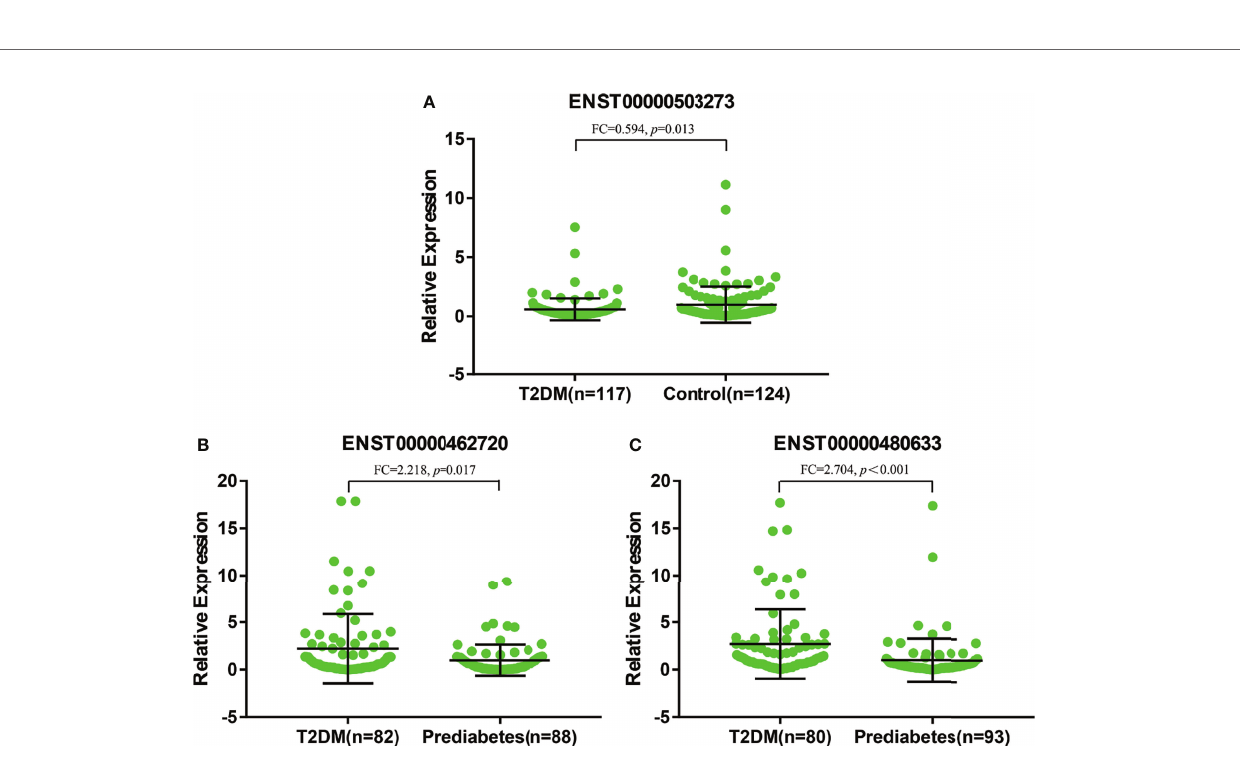
FIGURE 6 | (A) represented relative expression of lncRNAs for ENST00000503273 between T2DM and normal controls. (B, C) represented relative expression of lncRNAs for ENST00000462720 and ENST00000480633 between T2DM and prediabetes,